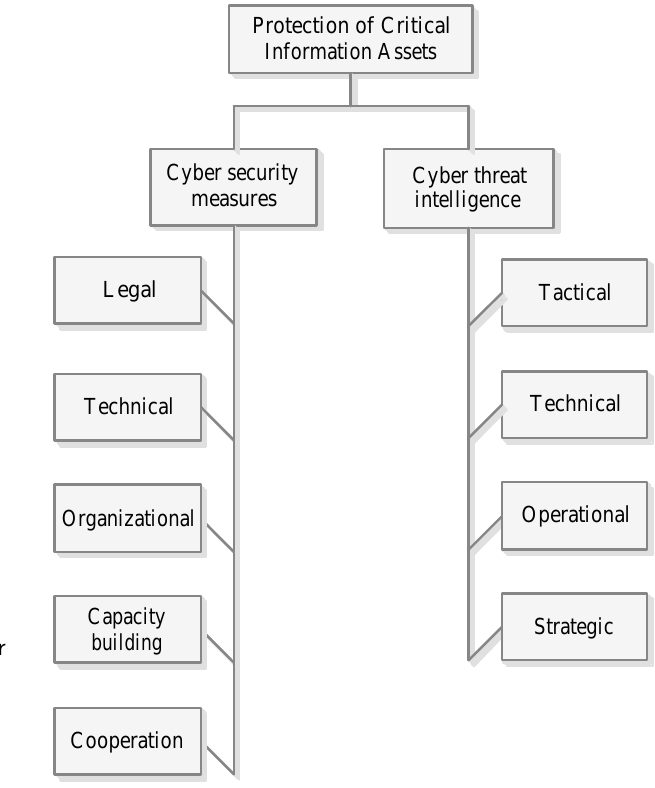
Figure 4. Measures for the protection of critical information